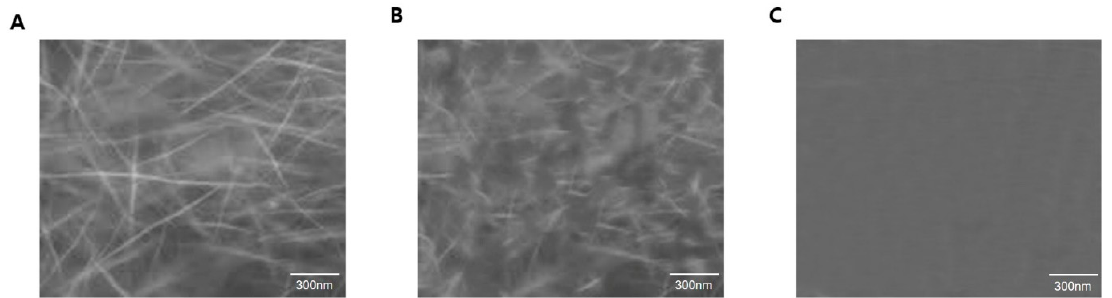
Figure 7. TEM images of polymerized P. capsici microtubules. α , β -tubulin were polymerized for 40 min. ( A ) Microtubules were observed without peptide. ( B ) Amorphous morphology of microtubules occurred predominantly with 1 µ M of α _P2. ( C ) Ten micromolar α _P2 completely inhibited the formation of microtubules. As the concentration of peptide increased, the extent of polymerization was inhibited. The scale bar corresponds to 300 nm.